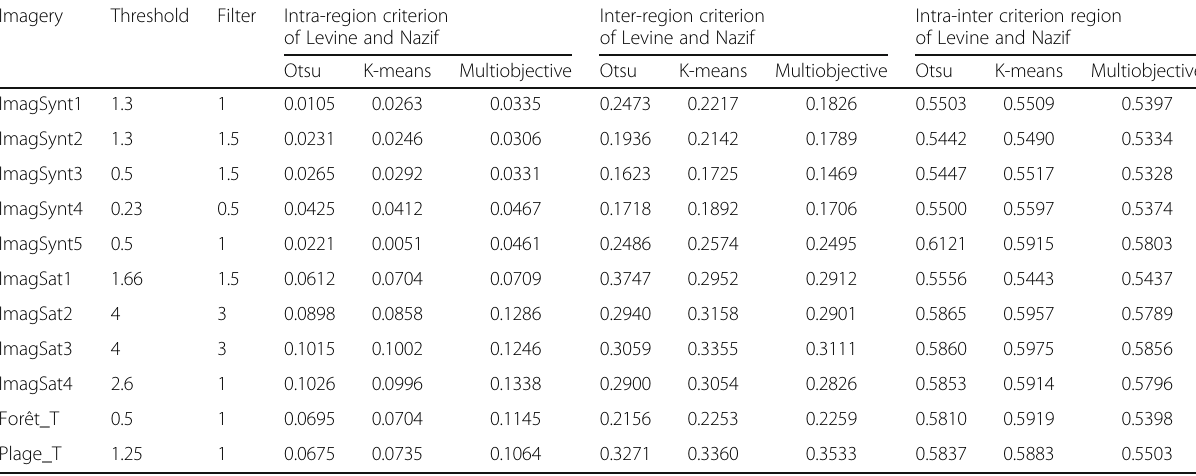
Inter-region criterion of Levine and Nazif